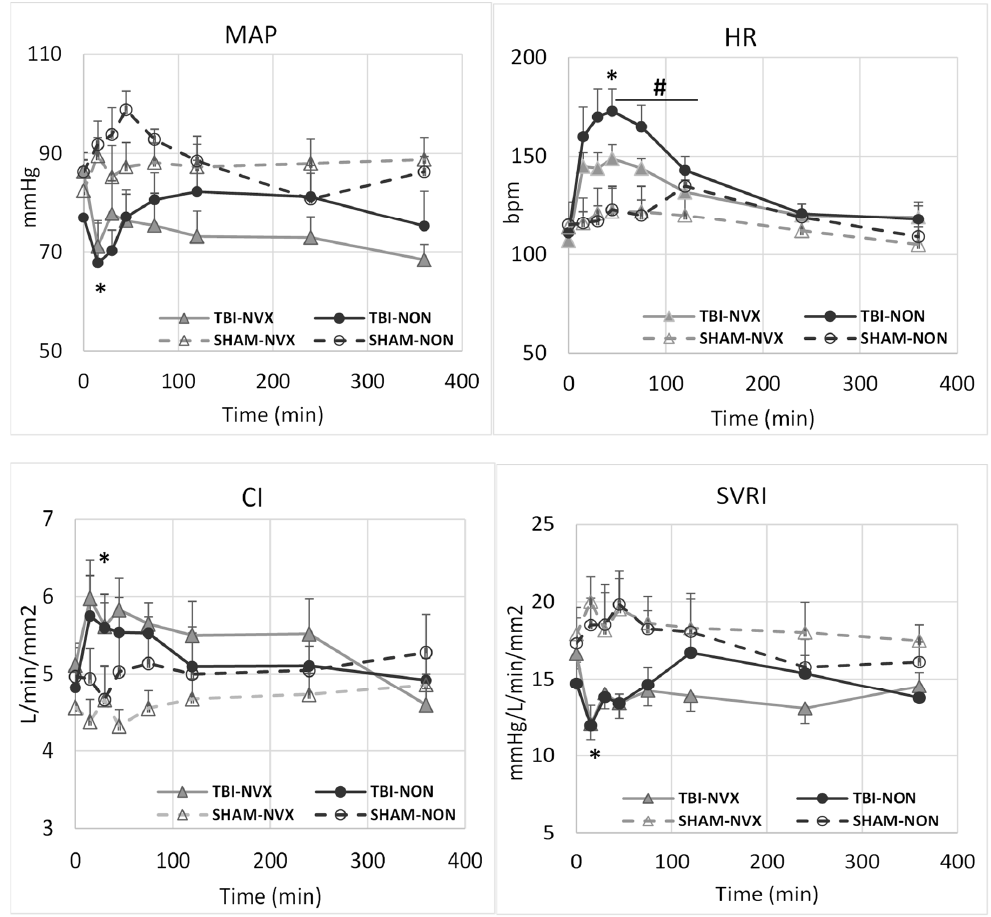
Figure 1. Mean arterial pressure (MAP), heart rate (HR), cardiac index (CI) and systemic vascular resistance index (SVRI) for the TBI-NVX, TBI-NON, SHAM-NVX and SHAM-NON groups. * p <0.01; significant difference between TBI vs. SHAM (combined TBI-NVX and TBI-NON vs. SHAM-NVX and SHAM-NON) indicating the initial physiological effect due to trauma. # p < 0.05; significant difference between TBI-NVX vs. TBI-NON or SHAM-NVX vs. SHAM-NON indicating the effect of NVX. Mean and standard deviation; SHAM-NON (-- ○ --), SHAM-NVX (-- ∆ --), TBI-NON ( ─ ● ─ ), TBI-NVX ( ─▲─ ). The only clinically relevant treatment-related hemodynamic effect was a rapid, transient (cid:35) increase in mean pulmonary artery pressure (MPAP) following the injection of NVX-428 (Figure 2). Compared to baseline, MPAP changed within the TBI-NVX group after NVX treatment. Specifically, compared to T0, MPAP was lower at T15 and higher at T30 and T240. Although a similar trend was visually apparent in the SHAM-NVX group, the increase in MPAP was not as large and was not significant ( p = 0.056; Figure 2). There were no differences in overall MPAP between TBI-NVX vs. TBI- NON or between SHAM-NVX vs. SHAM-NON, following the particularly transient nature of the MPAP increases.